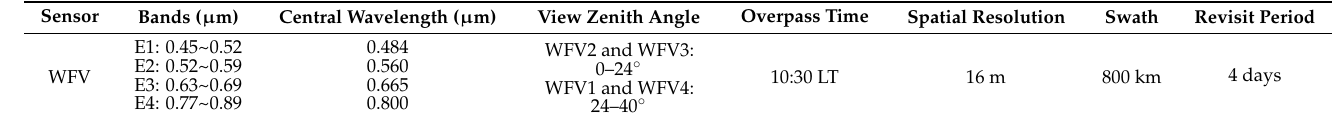
Table 1. Parameter configuration of GF ‐ 1/WFV.